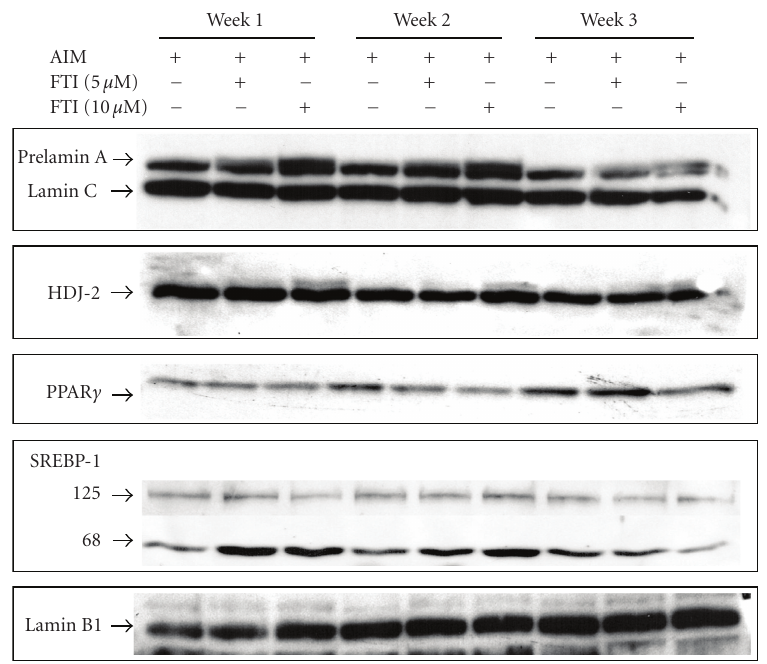
Figure 4: E ff ect of FTI-277 on protein farnesylation and transcription factors for adipogenesis in di ff erentiating MSCs: human MSCs were plated in 6-well plates as previously described. After confluence, media were replaced with AIM with FTI-277 (5 and 10 μ M) or vehicle alone. Media were replaced every three days for three weeks. Nuclear extracts were obtained at weeks 1, 2, and 3 of di ff erentiation and treated as described in Materials and Methods. Membranes were incubated overnight at 4 ◦ C using an antibody directed against either prelamin A, HDJ-2, PPAR γ , SREBP-1, and lamin B1. The bound antibodies were detected with the corresponding secondary antibodies conjugated with horseradish peroxidase. Blots were developed by enhanced chemiluminescence using Perkin-Elmer reagents. Treatment with increasing doses of FTI-277 induced an increase in both, prelamin A and unfarnesylated HDJ-2 expression (second upper band) suggesting that FTI- 277 was e ff ective on inhibiting farnesylation in this model of MSCs di ff erentiation. Although a lower expression of both prelamin A and HDJ-2 at week 3 of di ff erentiation was found, the presence of an upper band in the treated cells suggests that inhibition of farnesylation by FTI-277 was still e ff ective. Furthermore, inhibition of farnesylation correlates with lower levels of PPAR γ . Finally, at weeks 1 and 2, a sharp SREBP-1 68-kDa band (mature) correlates with higher levels of prelamin A expression whereas the 125-kDa precursor proteins is much less intensely stained. These results suggest that inhibition of farnesylation a ff ects adipogenesis due to reduced expression of PPAR γ which correlate with higher levels of mature SREBP-1. Membranes were stripped and immunoblotted for lamin B1 levels to demonstrate equal loading of proteins. The images are representative of three di ff erent